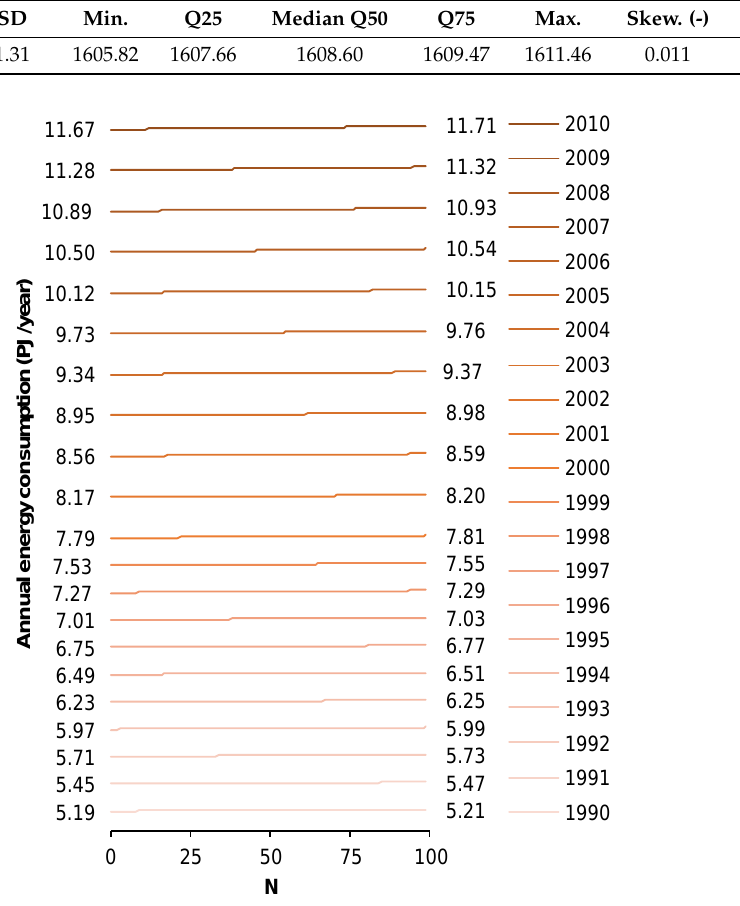
Figure 4. Normalized empirical distribution of the accumulated annual demand (energy consumption) by year for UTOPIA’s passenger transport sector.